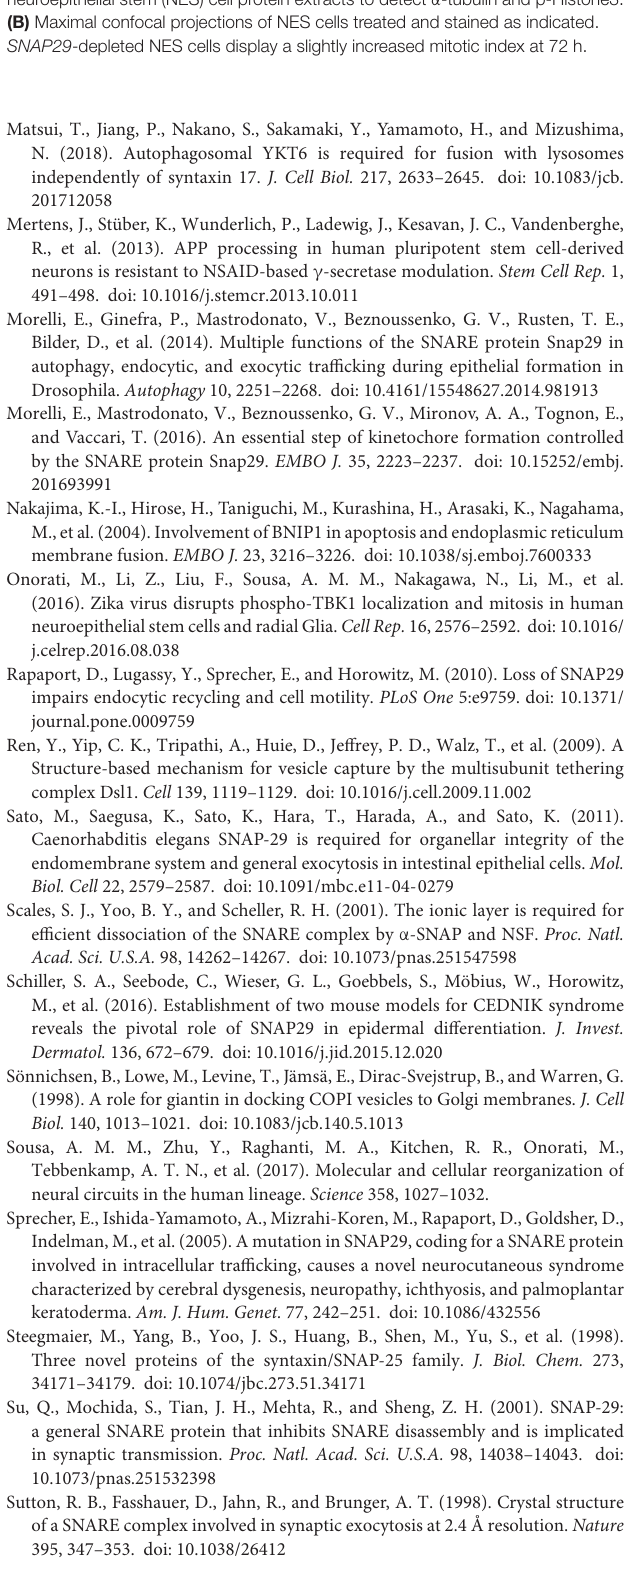
Supplementary Figure 6 | (A) Immunoblotting of total proteins from neuroepithelial stem (NES) cell protein extracts to detect α -tubulin and p-Histone3. (B) Maximal confocal projections of NES cells treated and stained as indicated. SNAP29 -depleted NES cells display a slightly increased mitotic index at 72